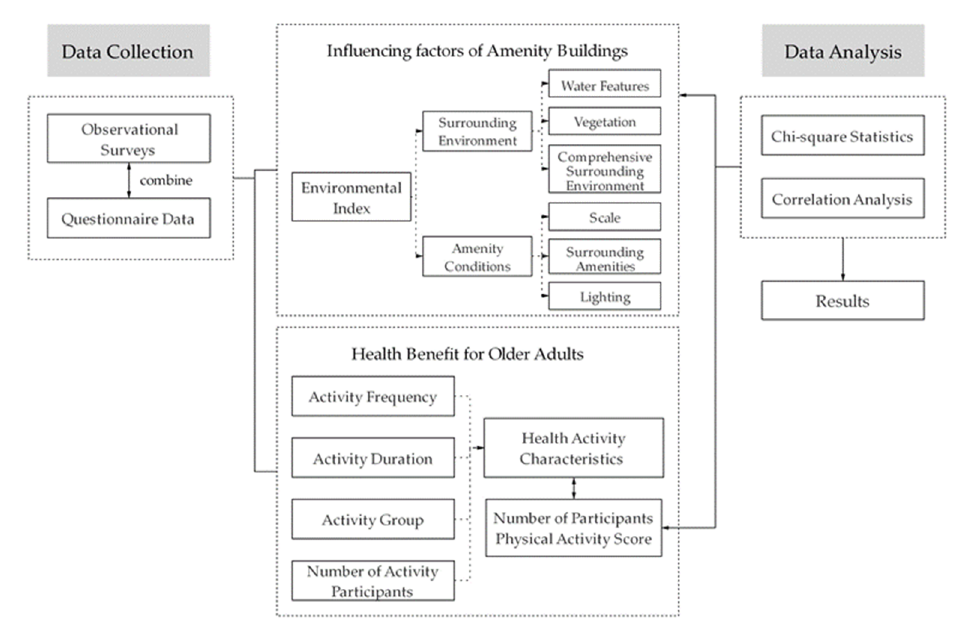
Figure 1. Research plan overview .